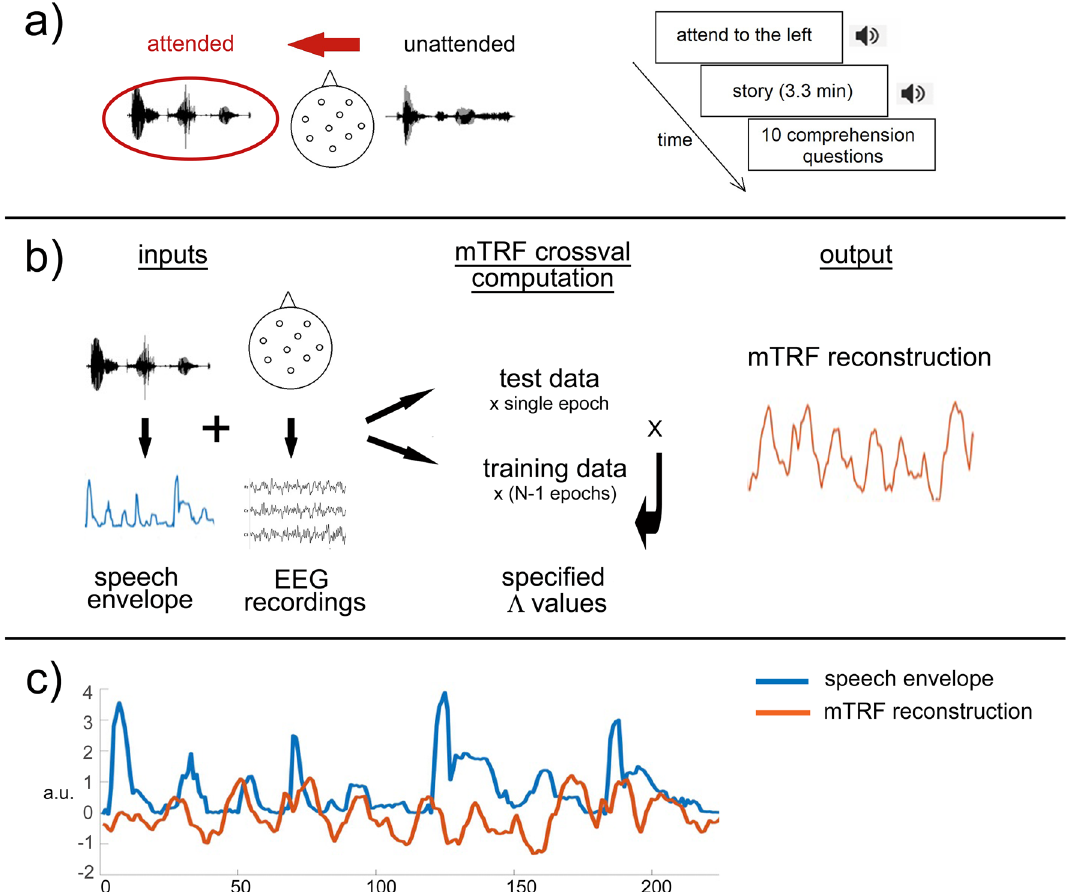
Figure 1. Experimental procedure and mTRF model computation. ( a ) Procedure: Children were instructed to attend to one side. The stimuli were presented for 3.3 min, and children were then asked to complete